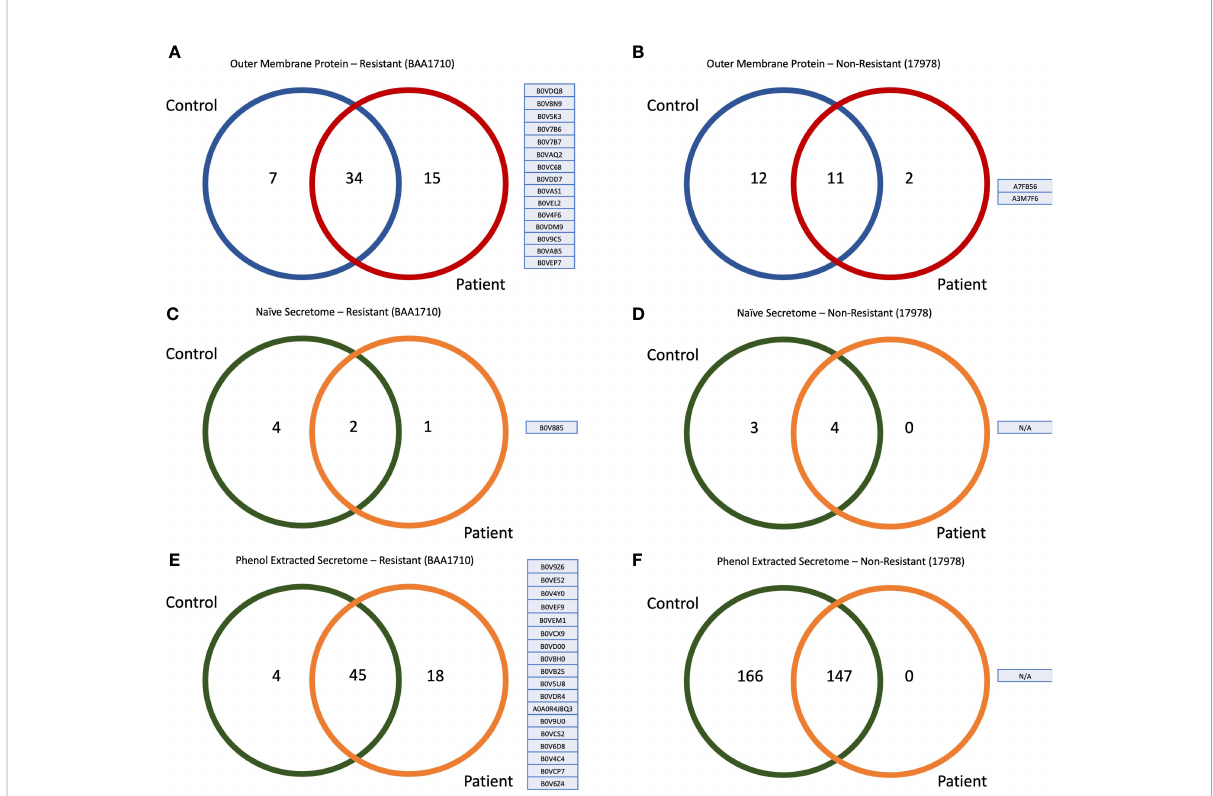
FIGURE 2 Venn diagram and accession numbers of the identi fi ed proteins from diverse groups. (A) Fifteen outer-membrane proteins of resistant strain captured via patient sera and their accession numbers. (B) Two outer-membrane proteins of sensitive strain captured via patient sera and their accession numbers. (C) One secretome protein of resistant strain that captured via patient sera without any enrichment protocol and its accession number. (D) No antigenic secretome protein of sensitive strain was captured with patient sera in naïve form. (E) Eighteen secretome proteins of resistant strain captured via patient sera after enrichment with phenol extraction and their accession numbers. (F) No antigenic secretome protein of sensitive strain was captured with patient sera after phenol